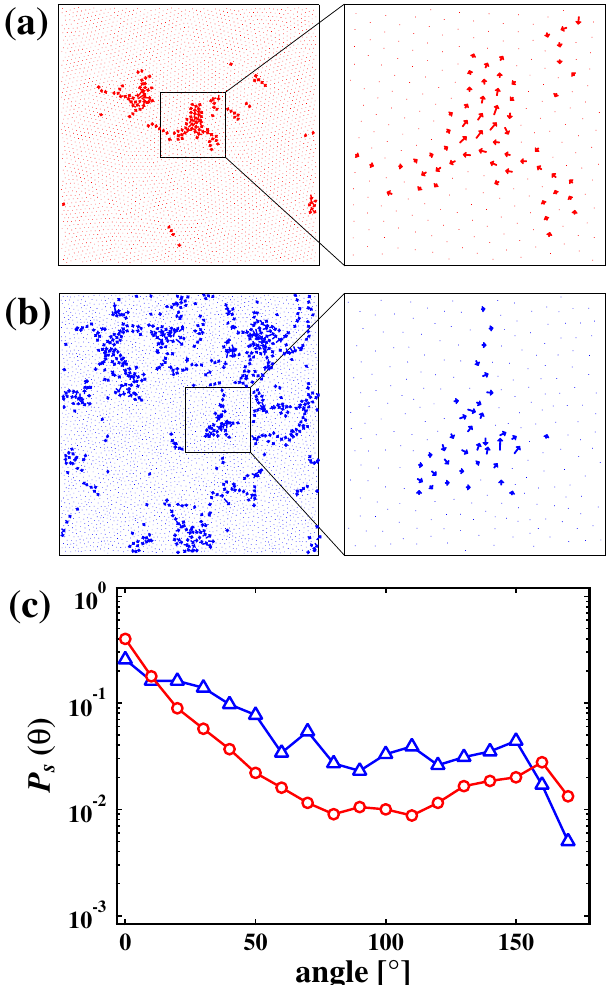
Figure 6. Displacement vector field of particles with ( a ) σ = 0.10 and ( b ) σ = 0.20 over the time interval 4.0 × 10 4 to 1.0 × 10 5 and 2.5 × 10 4 to 1.0 × 10 5 , respectively. We change φ v from 0.114 to 0.125 for σ = 0.10 and from 0.116 to 0.128 for σ = 0.20. The left images are zoomed in on a collective motion regions for the simulation systems. Vectors are shown the ten times larger than their actual lengths for visibility. ( c ) Probability distribution P s (θ) for the angle between displacement vectors of particles in contact each other. Red circle and blue triangle symbols indicate particles with σ = 0.10 and σ = 0.20,